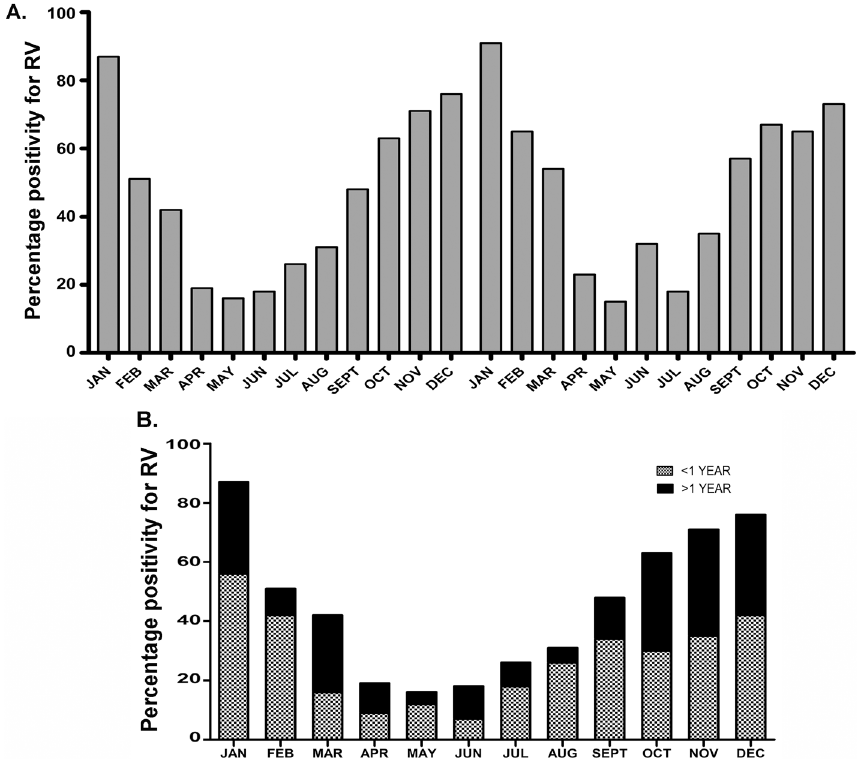
Fig 1. Percentage distribution of Rotavirus-positivity among hospitalalized infants < 2 yrs age suffering from severe diarrhea in Patna. (A-B) Temporal distribution of Rotavirus positivity: data of 2 consecutive years (A) and age wise stratified data among all patients (B). (C) Breast-feeding wise distribution of Rotavirus positivity among all patients.